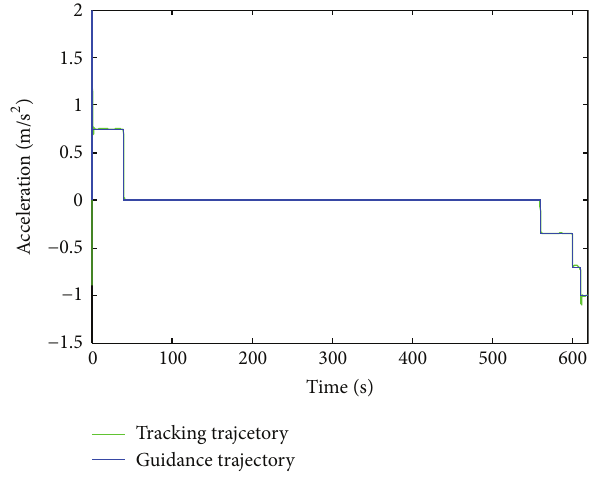
Figure 6: Train acceleration tracking curve (this paper).